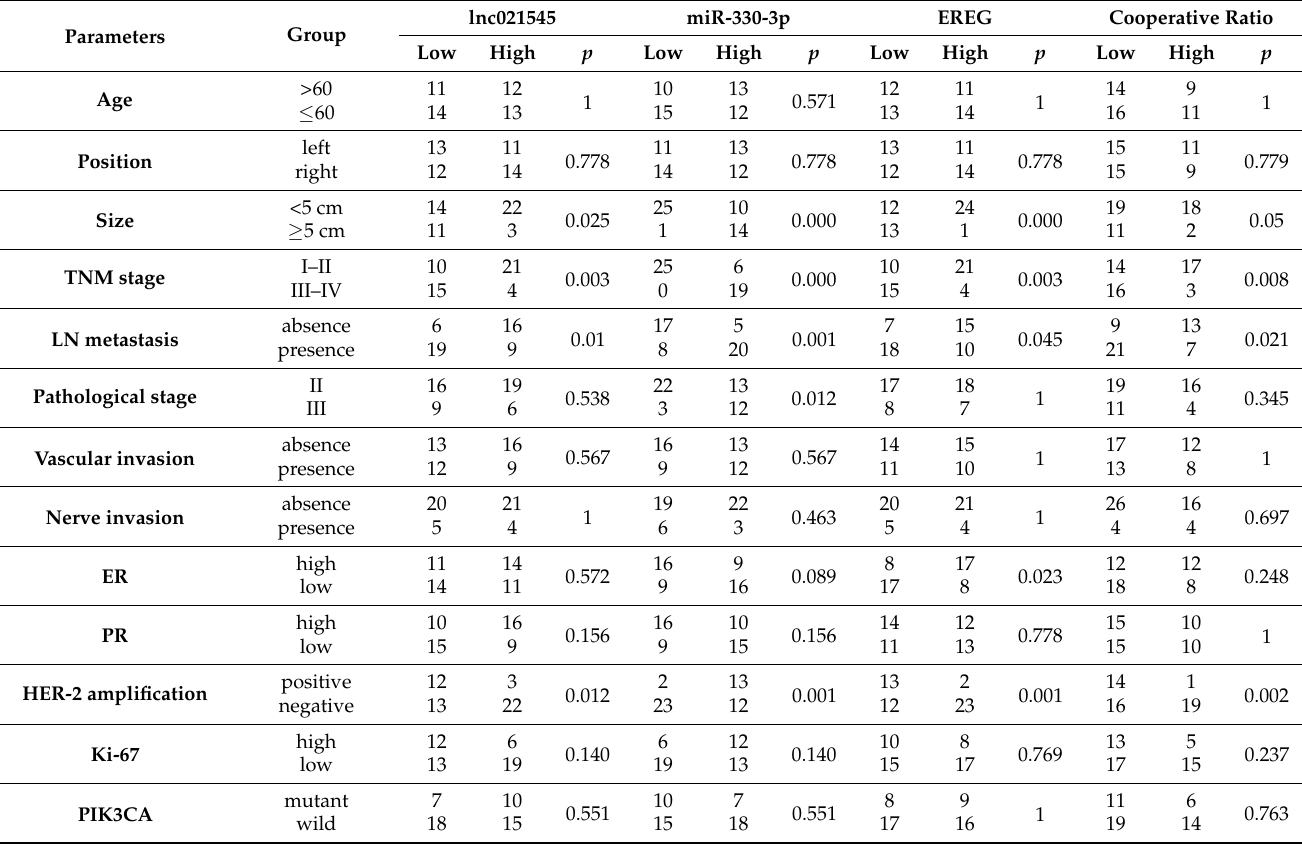
Table 1. Correlations of miR-330-3p, lnc021545, and EREG and their cooperative ratio with the clinicopathological features of 50 BC